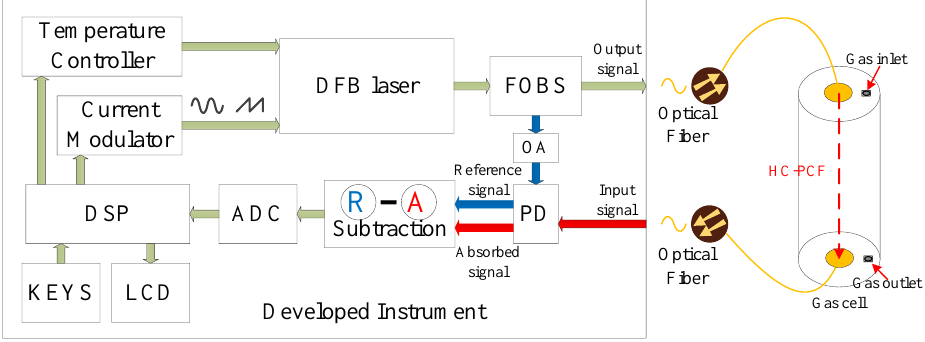
Figure 2. Developed near-infrared methane-detection system with HC-PCF gas cell.